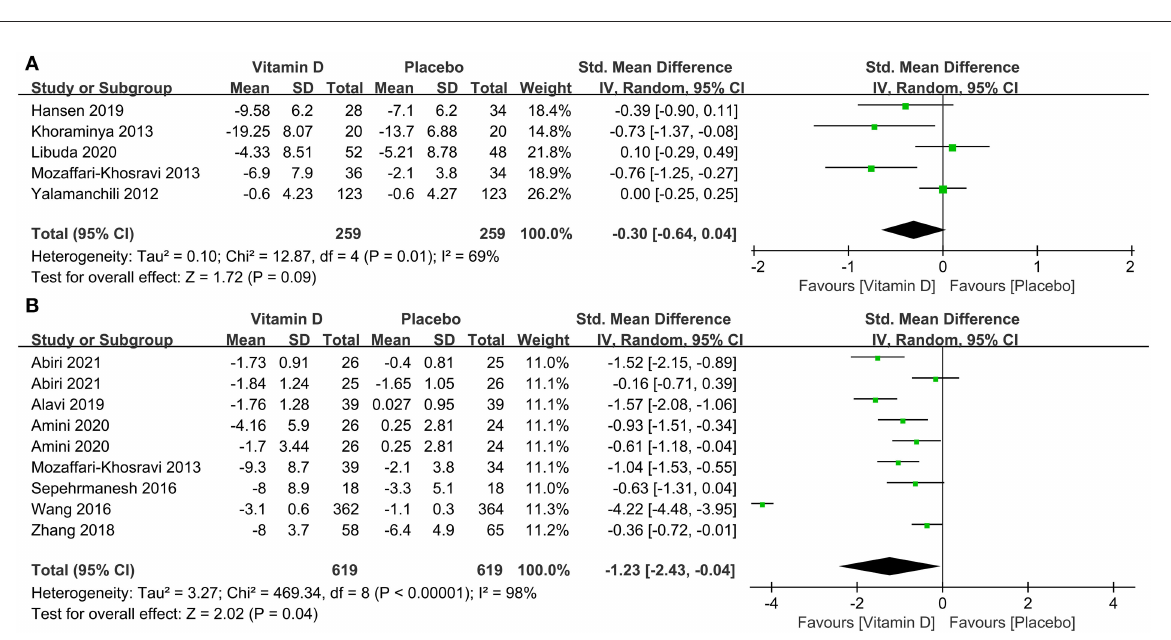
intervention duration ≤ 8 weeks (SMD: − 0.69; 95%CI: [ − 1.08, − 0.30]; p < 0.001) (Table